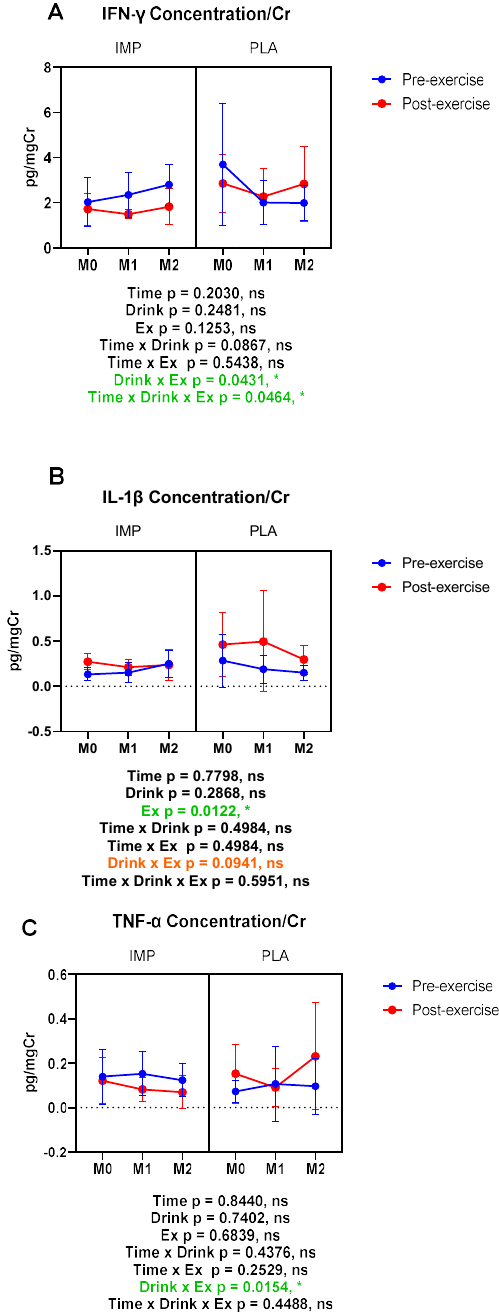
Figure 7. Urine interferon (IFN)- γ ( A ), interleukin (IL)-1 β ( B ), and tumor necrosis factor (TNF)- α ( C ) concentrations corrected with creatinine. The data are presented as means ± SD. * p < 0.05. Green text indicates a significance <0.05 and orange text indicates an interaction <0.05.